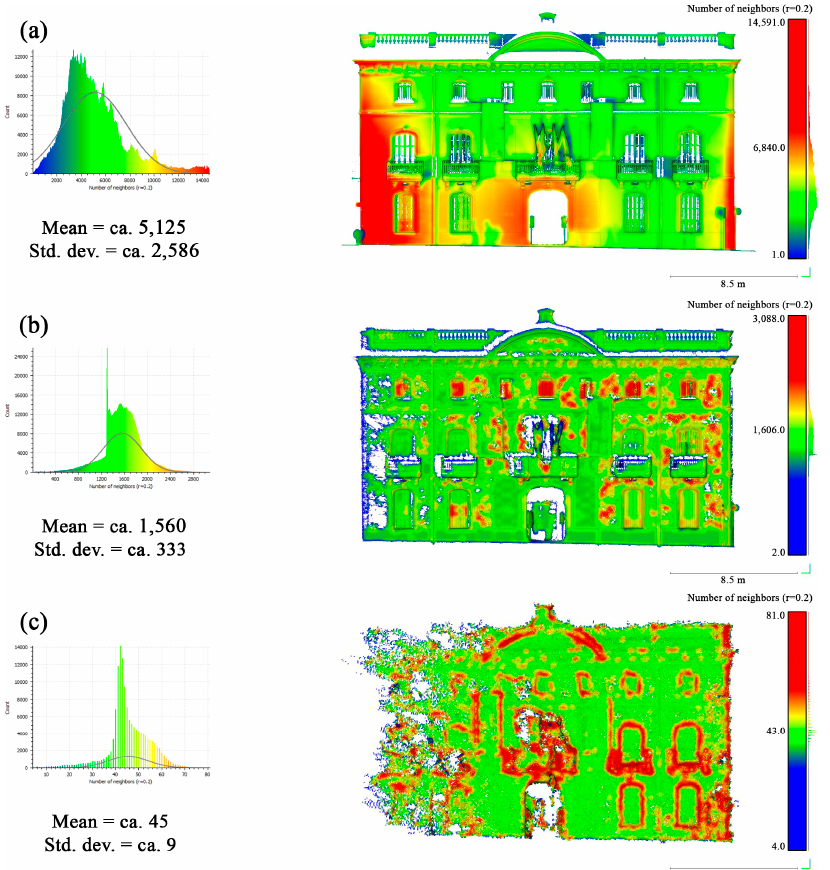
Figure 12. On the left, LiDAR point cloud of the southern façade. On the right, photogrammetric dense point cloud derived from TIR images.